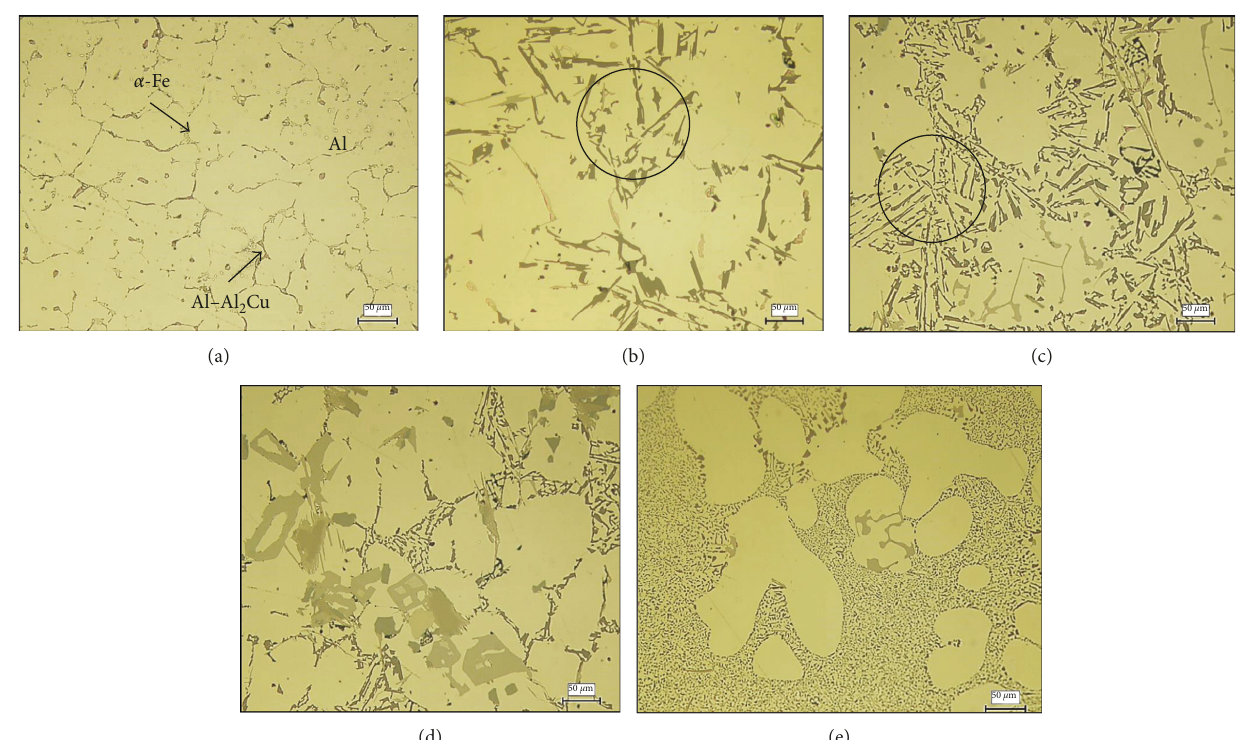
Figure 5: Optical microstructures obtained from (a) B0, (b) D0, (c) D0+5%Ce+0.15%Ti, (d) D0+5%La +0.15%Ti alloys, and (e) D0 alloy modified with 200ppm Sr (no RE was added). Note marginal modification in (c) compared to (b)—see black circled areas.